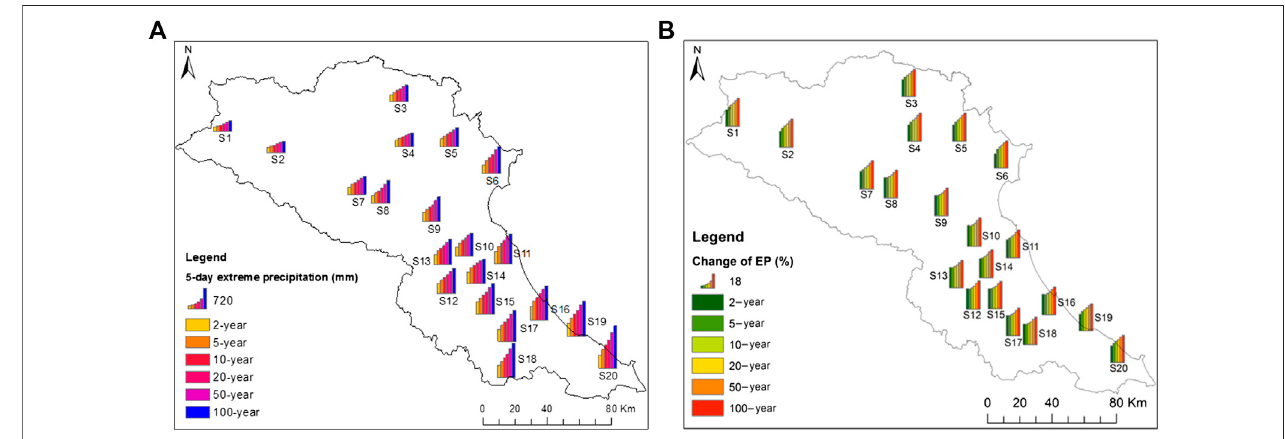
FIGURE 3 | Spatial variability of baseline 5-days extreme precipitation (A) and its change in 2070 according to RCP8.5 scenario (B) .